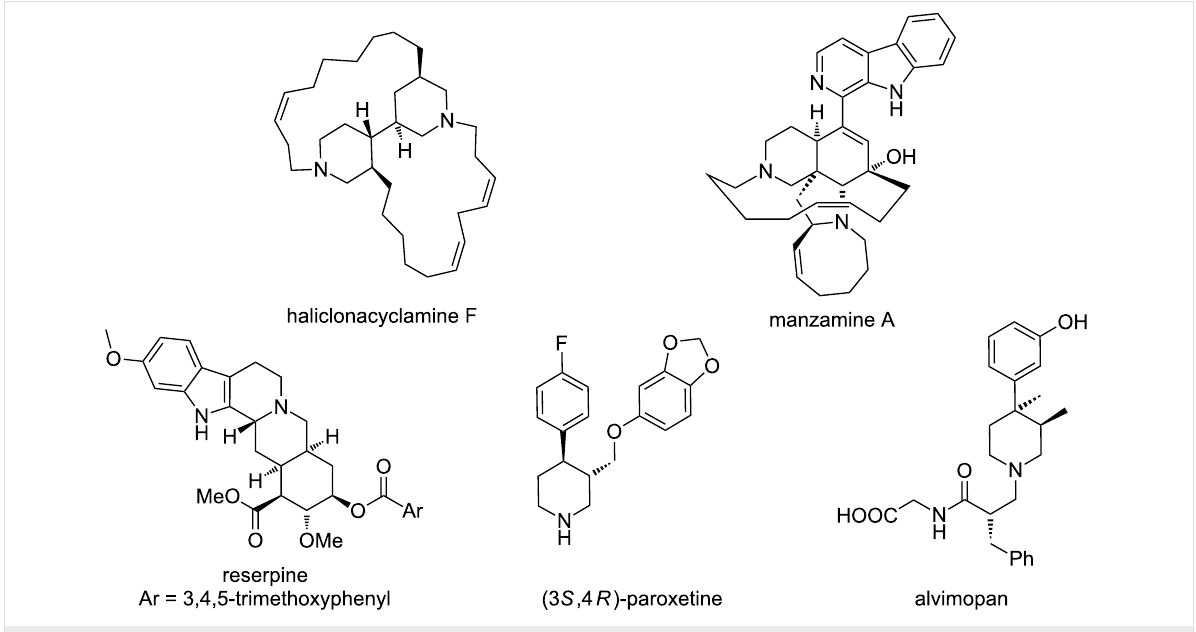
Figure 1: Biologically active natural products and drugs containing the piperidine ring.